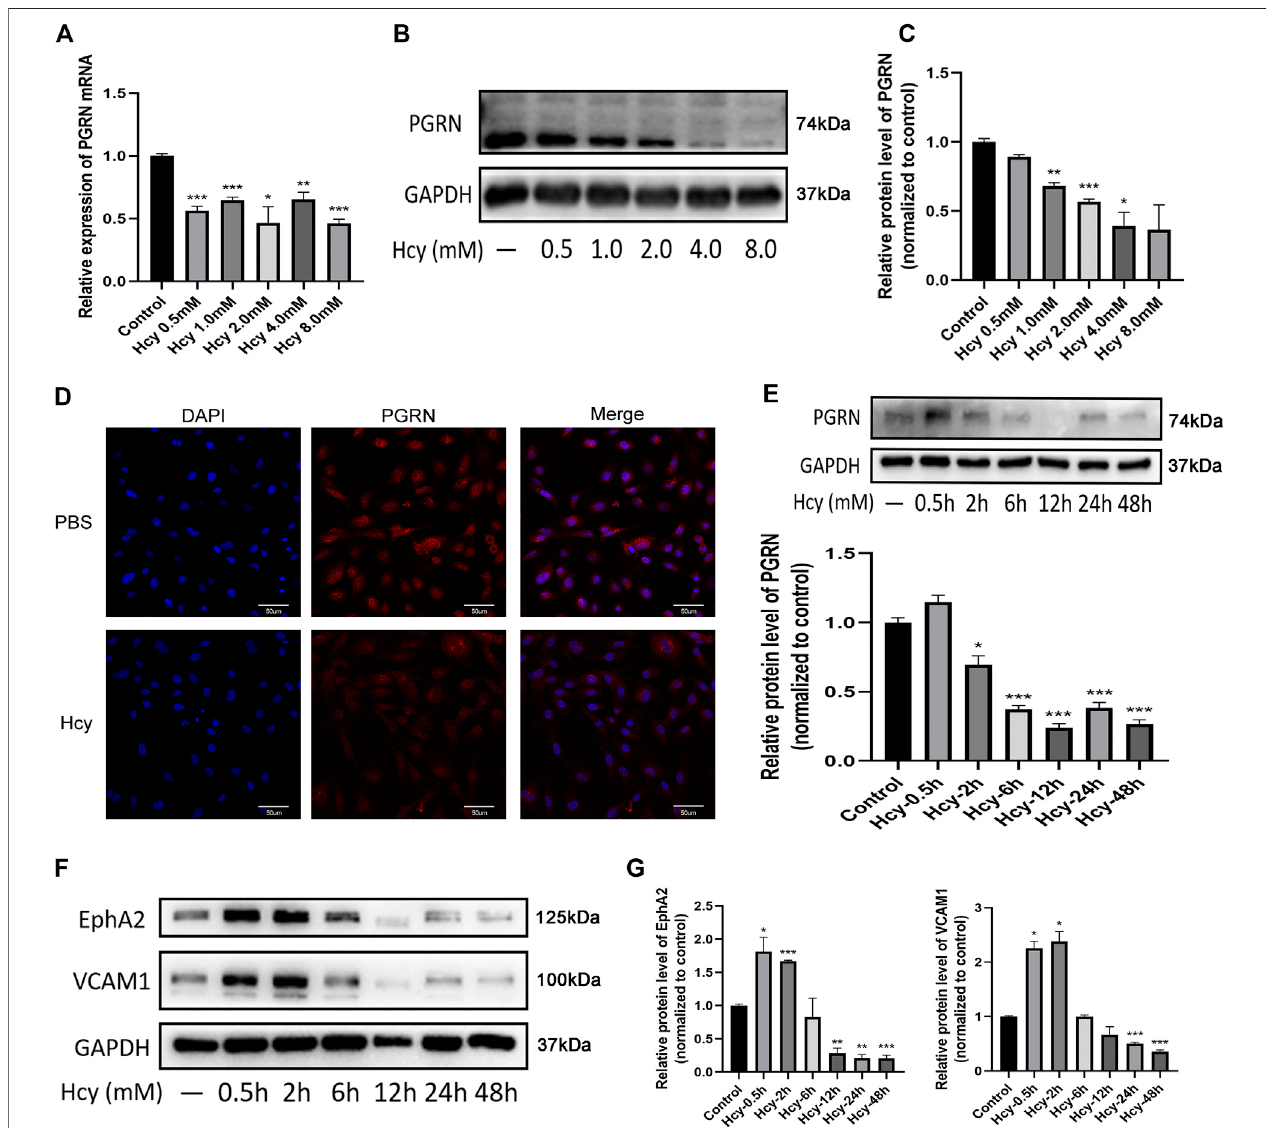
FIGURE 4 | Decreased levels of PGRN, EphA2, and VCAM1 after DL-Hcy treatment. (A) The Real-time PCR analysis of PGRN in HUVECs treated with different concentrationsofHcy (B,C) WesternblotanalysisofPGRNintheabsenceandpresenceofHcy(0.5,1.0,2.0,4.0,and8.0 mM)for24 h. (D) Immuno fl uorescenceresult of the distribution of PGRN (red) and DAPI (blue) in the absence and presence of Hcy 2.0 mM for 24 h. Scale bar, 50 μ m. (E) Western blotting analysis of PGRN stimulatedwith2.0 mMHcyatdifferenttimepoints(0.5,2,6,12,24,and48 h). (F,G) WesternblottinganalysisofEphA2andVCAM1levelsstimulatedwith2.0 mM Hcy at different time points (0.5, 2, 6, 12, 24, and 48 h). Data are presented as means ± SEM (* p < 0.05, ** p < 0.01, *** p < 0.001 vs. vehicle control, ANOVA, n (cid:1) 3).